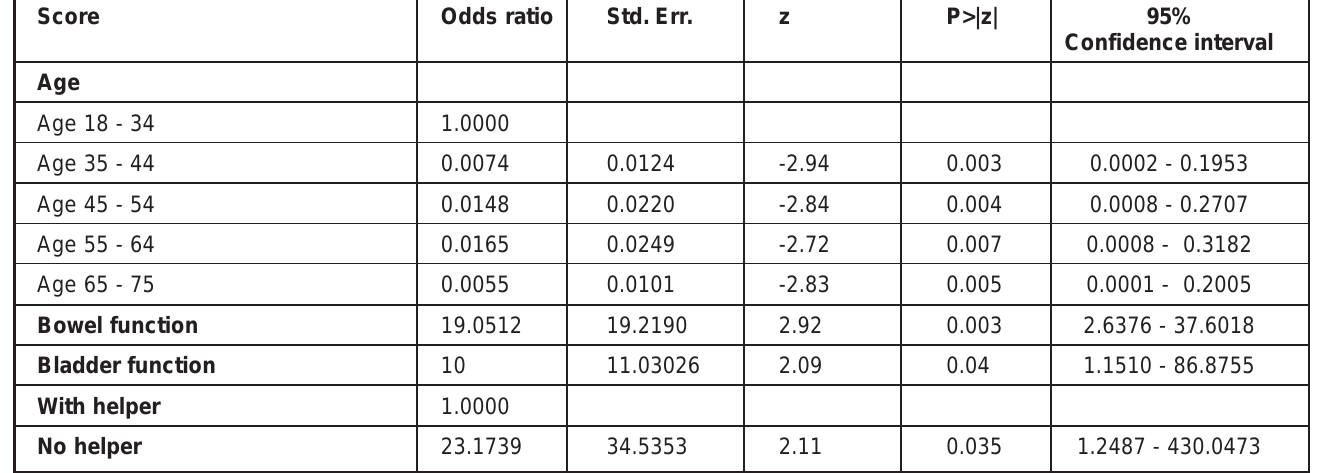
Table 3: Logistic regression and odds ratios results Score Odds ratio Std. Err.